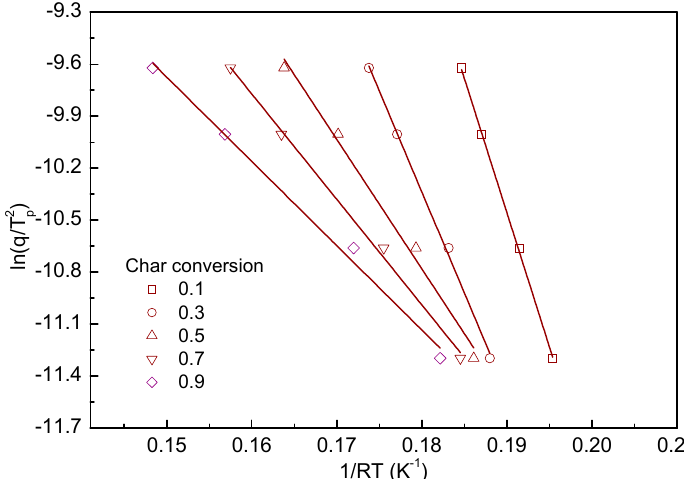
Figure 9. Kissinger kinetic plot of the wood pellet char for various char conversion values and heating rates.